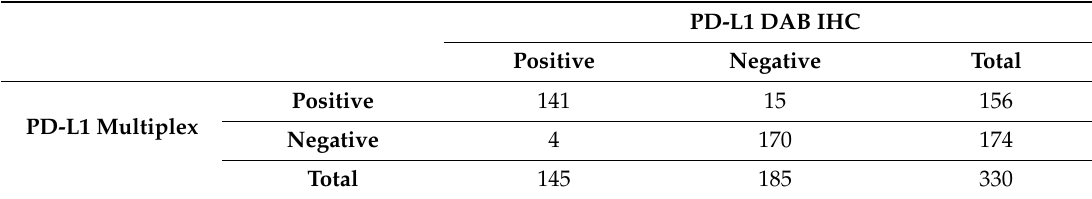
Table 2. Sensitivity and specificity data.